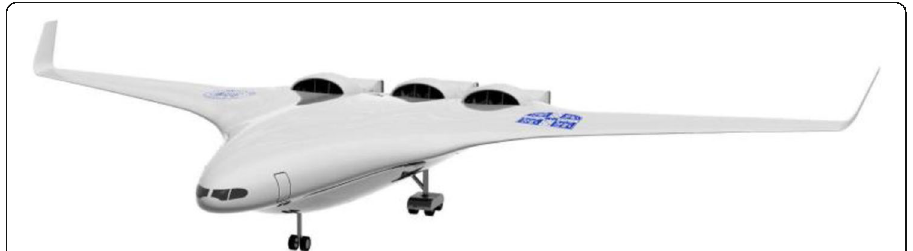
Fig. 5 Low noise BWB layout (SAX-40, see http://silentaircraft.org/)